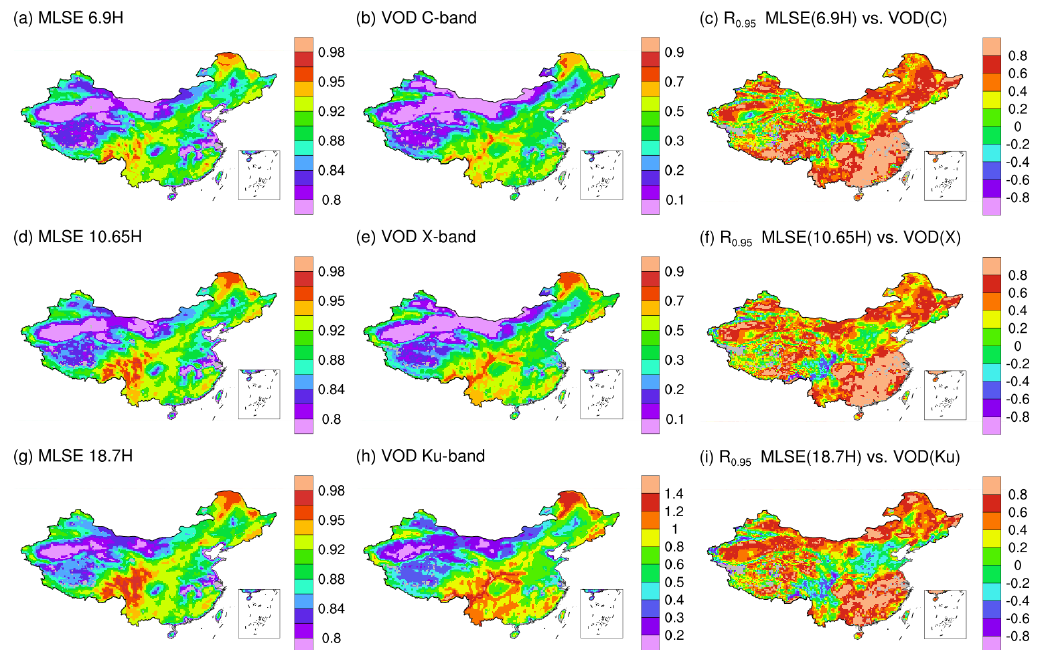
Figure 10. Spatial distributions of mean MLSEs at 6.9, 10.65 and 18.7GHz (horizontal polarizations, left panel), and mean VODCA VOD at C-, X- and Ku-bands (mid panel), and corresponding correlation coefficients (right panel) between the monthly mean MLSEs and VOD during 2003 – 2010.